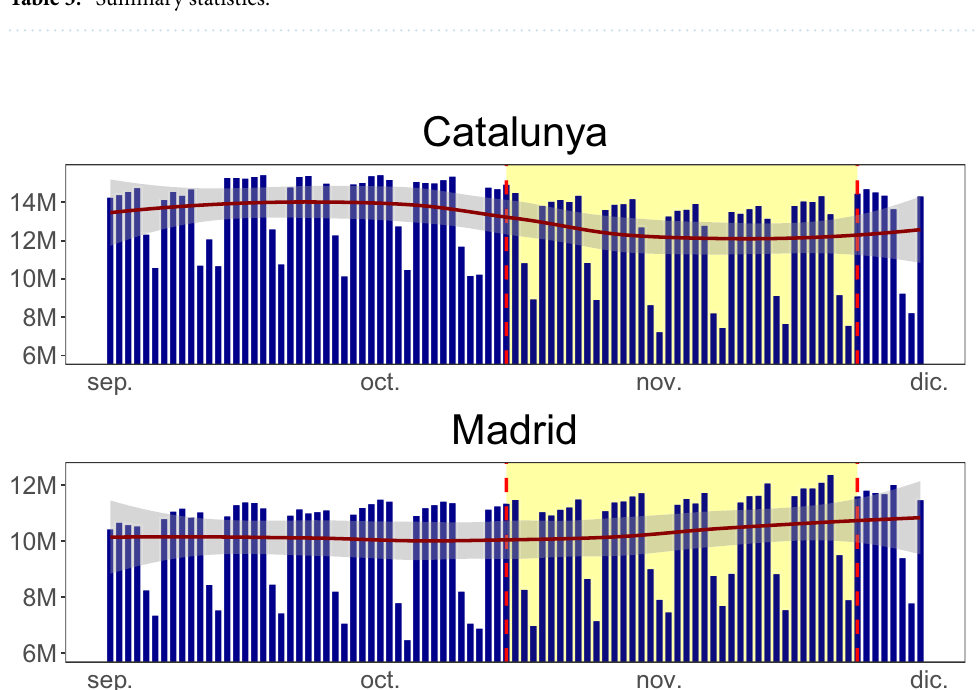
Figure 3. Number of trips in Cataluña and Madrid: the shaded region corresponds to the time duration when the bars and restaurants were closed in Cataluña. The pre-policy trend for both regions are relatively flat and parallel whereas the post-policy trend drops for Cataluña and not Madrid since the policy was only introduced in Cataluña. On the x-axis, dic refers to Diciembre